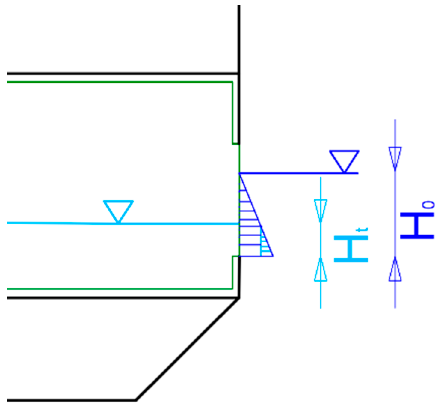
Figure 2. Transversal view of the damaged compartment with pressure distribution.